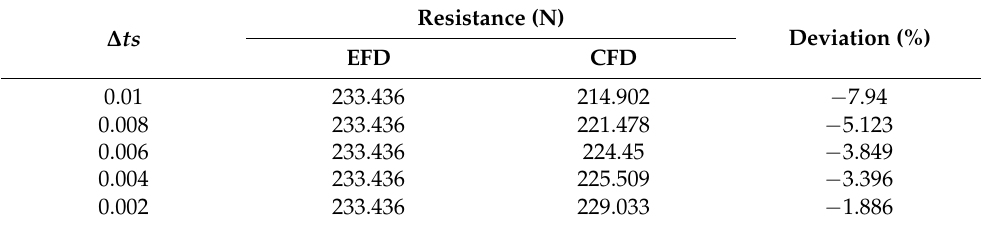
Table 6. The numerical results of resistance at different determination of time steps ( ∆ ts